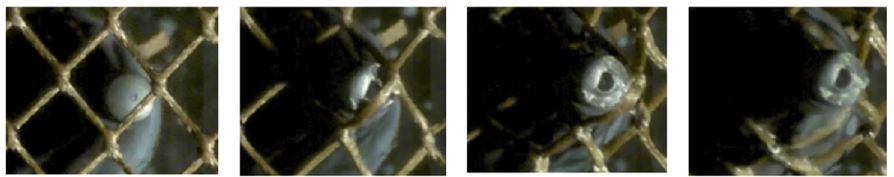
Figure 9. Sequence of stills from high-speed camera footage illustrating the slipping of the knot of a polymer fibre-based net cage armour system over the piezoelectric fuse.